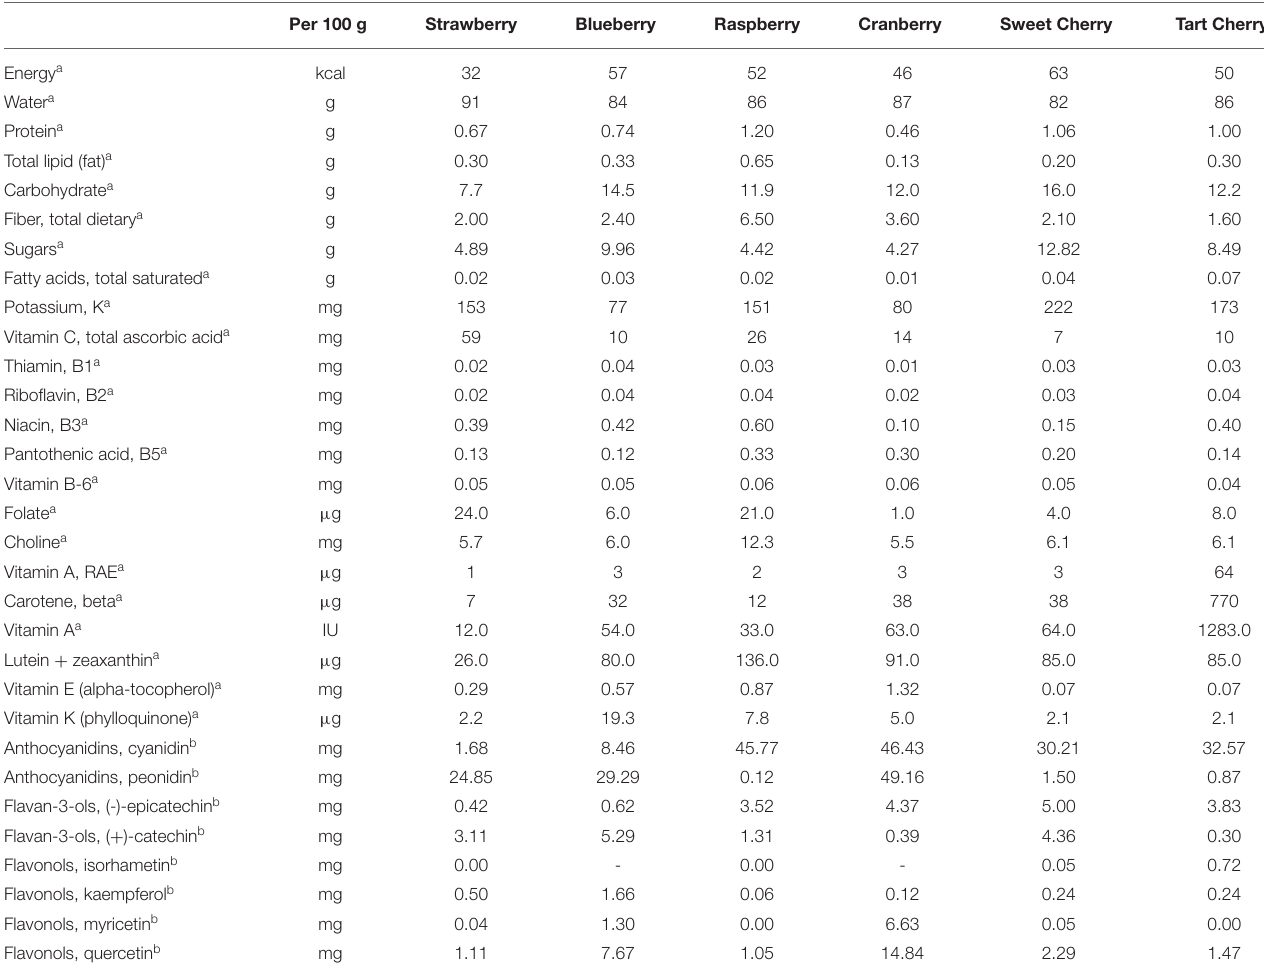
TABLE 1 | Comparison of major nutrients, vitamins and phenolic compounds between tart cherries and other common berries. Per 100 g Strawberry Blueberry